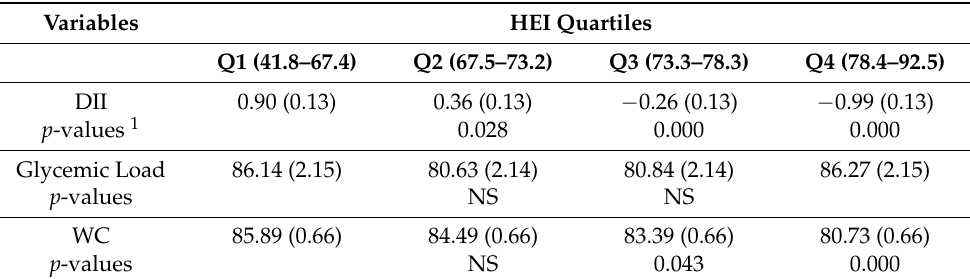
Figure 1. Radar plot showing the thirteen components of the Healthy Eating Index score stratified by WC for postmenopausal women who participated in the Minnesota Green Tea Trial. Mean HEI scores for those with WC > 88 cm and WC ≤ 88 cm were 73.7 and 75.4, respectively. Table 2. Dietary Inflammatory Index (DII), glycemic load, and waist circumference means stratified by quartiles of HEI score ( N =